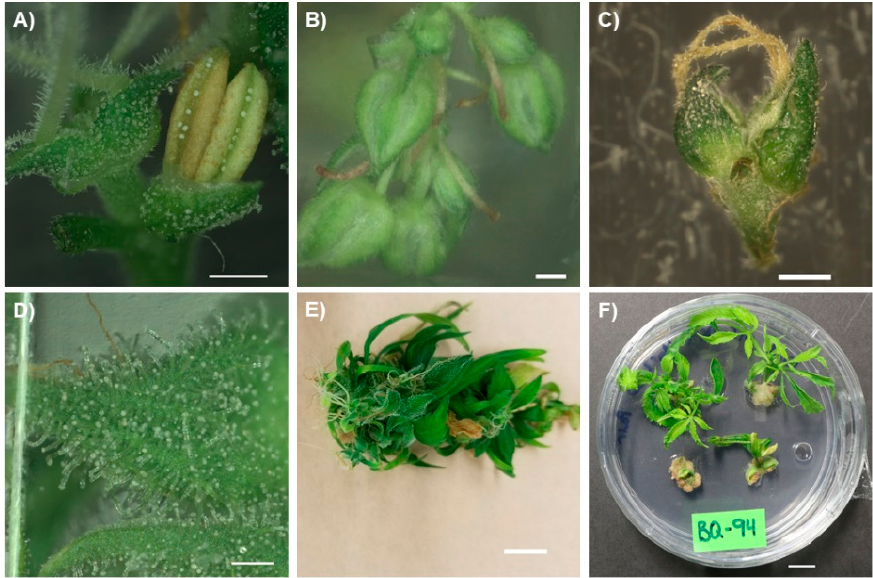
Figure 1. In Vitro flowering of Cannabis sativa. ( A ) Flowering C. sativa male plant displaying a hermaphroditic phenotype, showing female flowers (left) adjacent to male flowers (right). Scale bar—1 mm. ( B ) In Vitro male inflorescences of C. sativa . Scale bar—1 mm ( C ) A pair of female C. sativa florets obtained from In Vitro flowering C. sativa . Scale bar—1 mm. ( D ) Glandular trichomes developing on the bract surrounding the ovary of a female C. sativa inflorescence. Scale bar—2 mm. ( E ) Mature flowering In Vitro explant of C. sativa. Scale bar—1 cm. ( F ) Four-week-old vegetative explants reverted from In Vitro C. sativa inflorescences. Scale bar—1 cm.